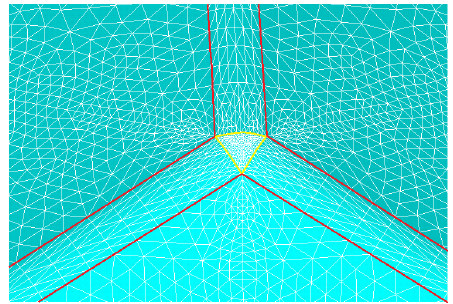
Figure 2. Mesh of the tip of the indenter with the bluntness 200 nm, (case A, red line shows the border of the blunted area, yellow the border between the blunted tip and the edge).